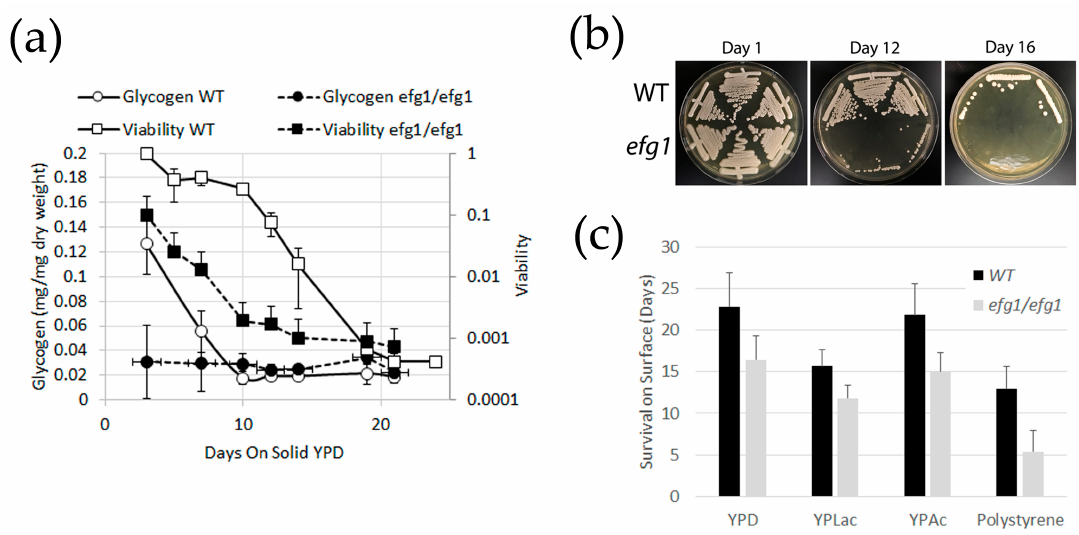
Figure 1. Glycogen content and viability of C. albicans wildtype (WT) SN152 and corresponding efg1/efg1 mutant. (a) Glycogen content of WT reaches a low after 10 days of culture on YPD media. Viability declines around day 10 of culture. efg1 null mutants have a low glycogen content from the start and viability declines more rapidly than in the WT; (b) Validation of a mechanical isolation assay to assess viability of cultures, confirming loss of viability at day 16 (WT) and 12 ( efg1 / efg1 ). (c) Viability of efg1/efg1 mutant on a variety of solid media. In each case, the difference between WT and mutant is significant ( p < 0.05).